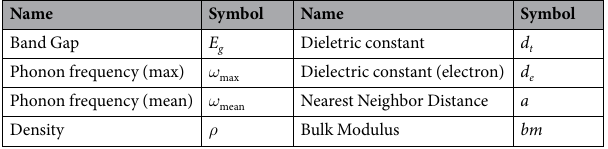
Table 1. Eight feature properties related to dielectric breakdown